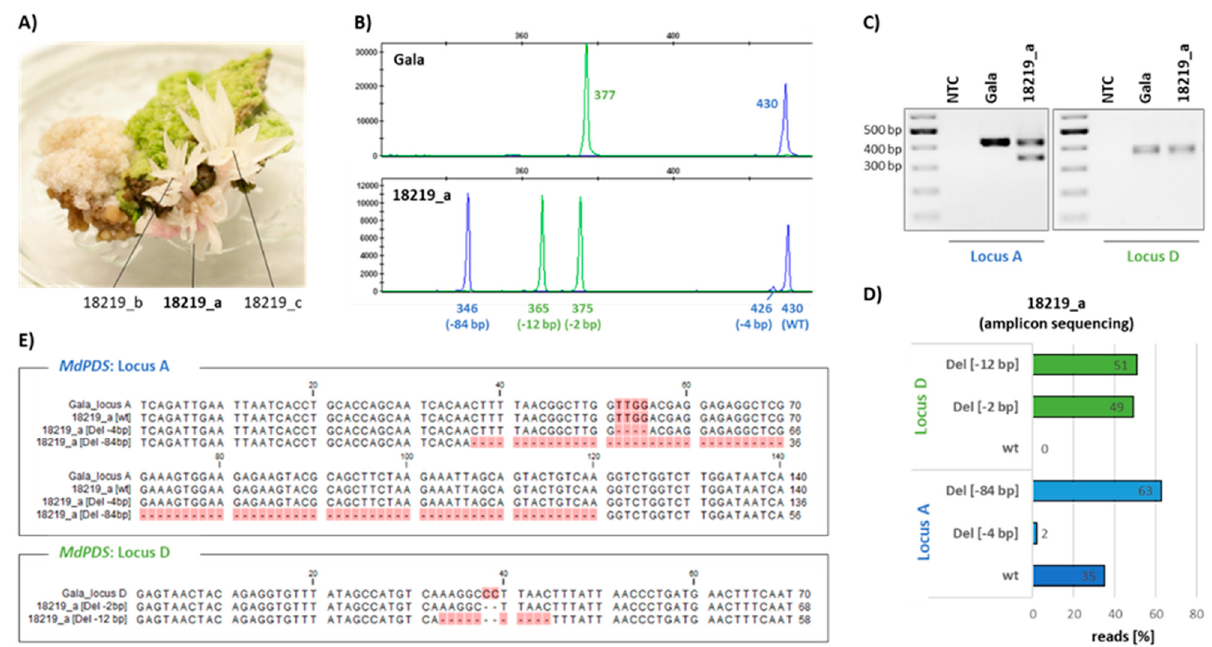
Figure 3. Molecular characterization of albino in vitro shoots by fluorescent PCR capillary electrophoresis and amplicon deep sequencing. ( A ) Single regenerated shoots exhibiting the albino phenotype were used to analyze GE events in target loci A and D within the MdPDS gene. ( B ) The MdPDS target loci were amplified by PCR using specific primer pairs labeled with fluorescent dyes (locus A: 6-FAM (blue); locus D: Atto532 (green)). The fragment lengths of the PCR products were determined by capillary gel electrophoresis. The resulting chromatograms (x-axis: fragment size; y-axis: fluorescence intensity (RFU)) are displayed for the non-transgenic wild type ‘Gala’ and the transgenic shoot 18219_a. The fragment lengths, as well as their deviation compared to the wild type alleles, are indicated. ( C , D ) PCR products flanking loci A and D were amplified from the identical template DNA with the same, but unlabeled, primer pair and analyzed by amplicon deep sequencing (NTC: no template control). The abundance of unique sequences and their difference in length compared to the reference sequence of ‘Gala’ was calculated (Del: deletion; wt: wild type). The diagram represents the percentage of total reads of the unique sequences. ( E ) The obtained unique sequences were aligned to the reference sequence of wt ‘Gala’. Differences from the consensus sequence are highlighted.